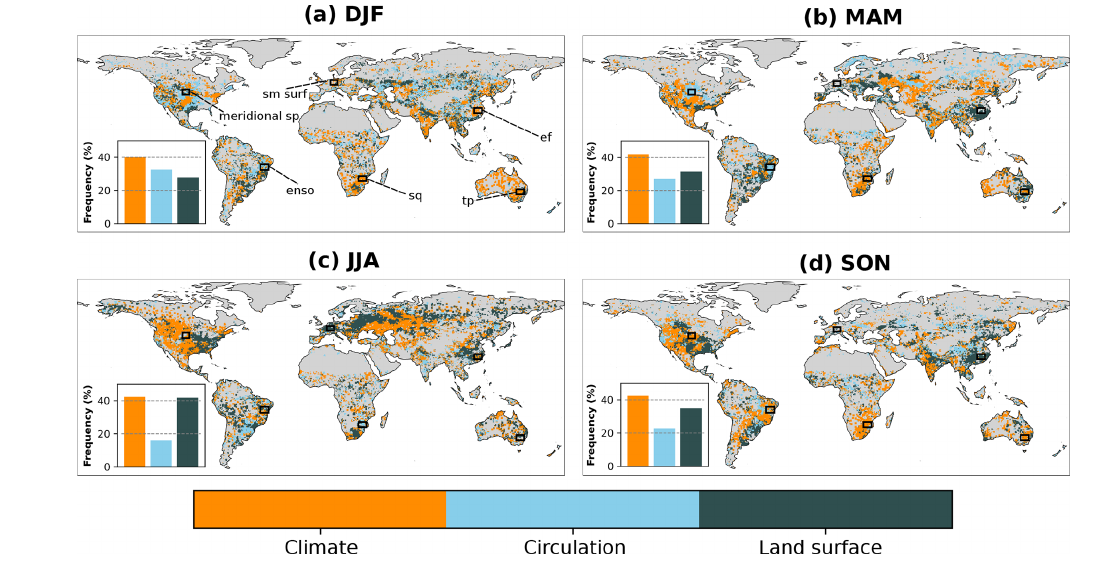
Figure 3. Groups of Earth system variables to which the variable with the strongest correlation with temperature forecast error belongs (based on Fig. A3). Results shown for each season (DJF, MAM, JJA, SON). The inset bar plots show the percentage of grid cells where variables from each group are most related to temperature forecast errors. The regions outlined in black are discussed in detail in Sect. 3.3: specific humidity region (sq), evaporative fraction region (ef), total precipitation region (tp), surface soil moisture region (sm surf), meridional surface pressure differences region (meridional sp), and ENSO region (enso). Table 3. The three most important variables for each group of variables across seasons. The first number in parentheses is the absolute spatial average correlation of the variable with temperature forecast error. The second number in parenthesis is the variable’s frequency of occurrence as the most relevant